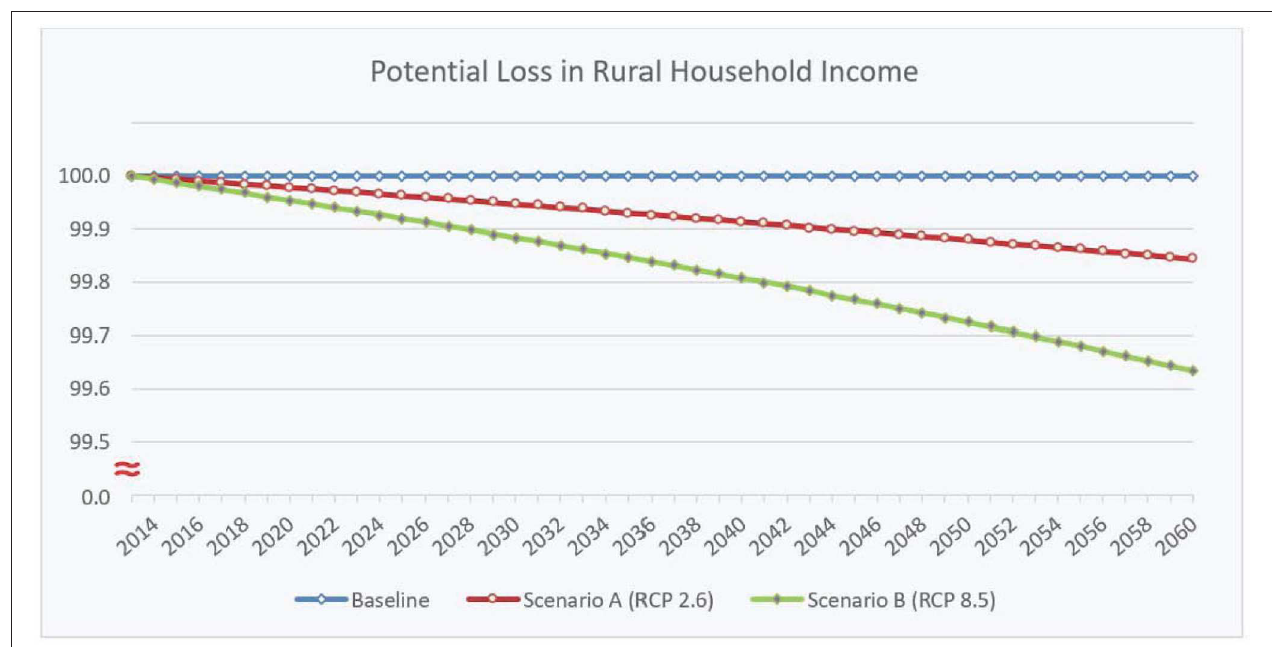
FIGURE 7 | Projection of loss in rural household income by scenario. Income level in base year is normalized to